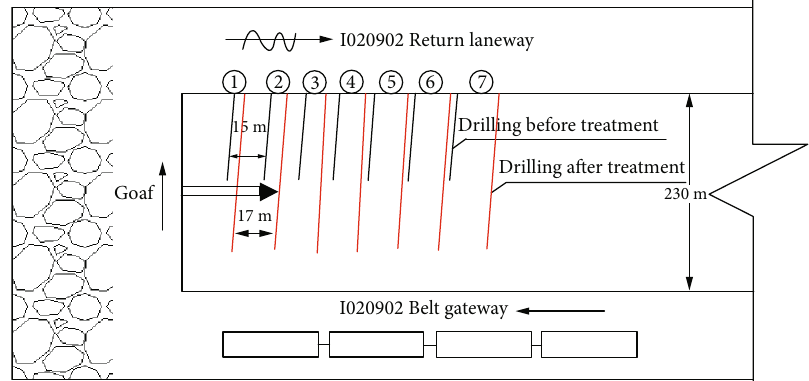
Figure 3: Comparison of the layout before and after dedusting drilling treatment.